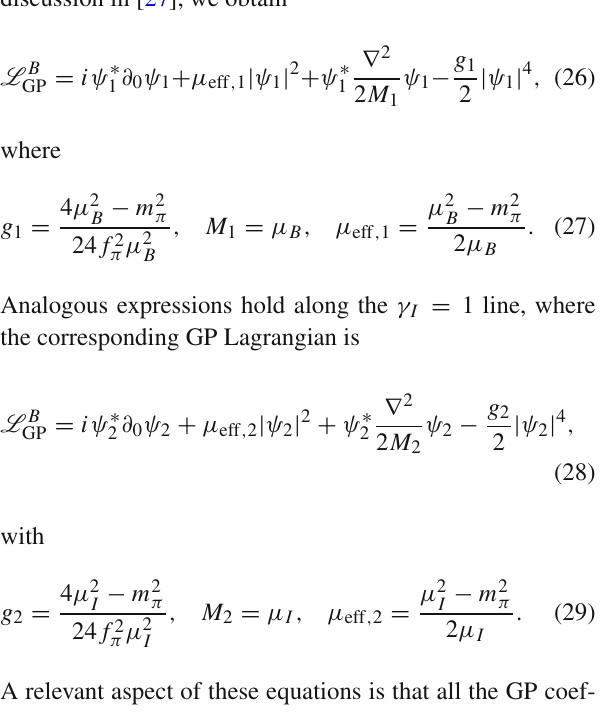
Fig. 2 Contour plots of the Ginzburg-Landau potential, see Eq. (22), as a function of N and π for γ B = 1 . 15 and increasing values of γ I . The lighter (yellow) regions correspond to minima. Left: case with γ = 1 . 12. The minimum is attained when the N fields gets a nonvan- I